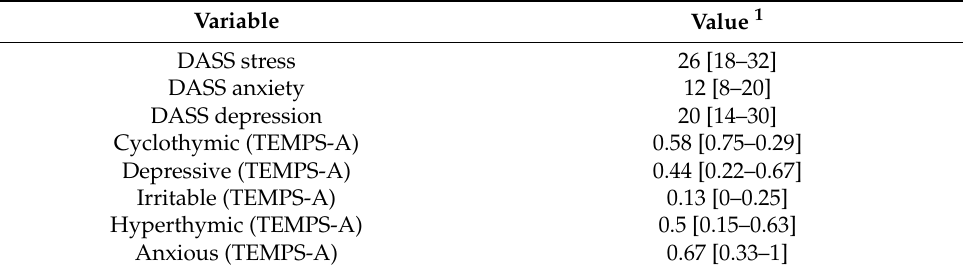
Table 3. Emotional temperament dimensions, stress, anxiety, and depression of the participants.